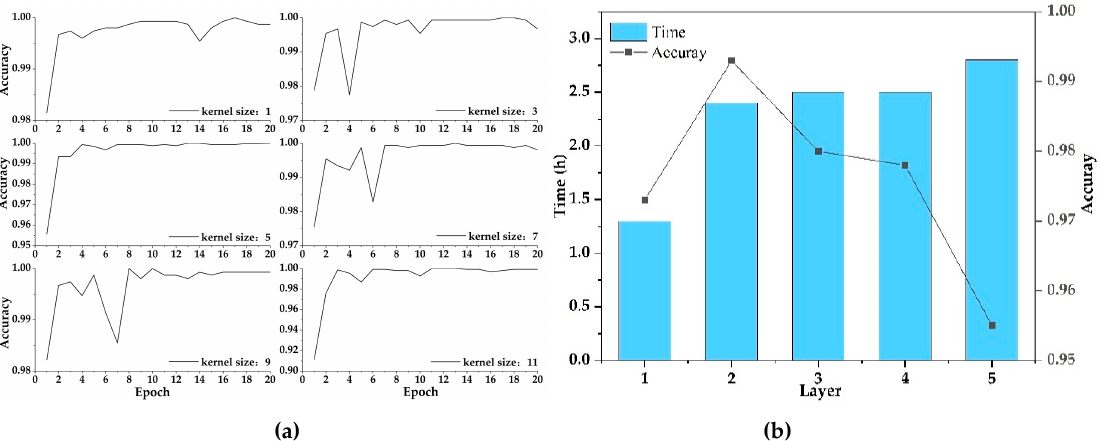
Figure 4. ( a ) Impact of kernel size on accuracy, and note that the y -axis scale of the six figures is different; ( b ) impact of layer on classification accuracy and efficiency